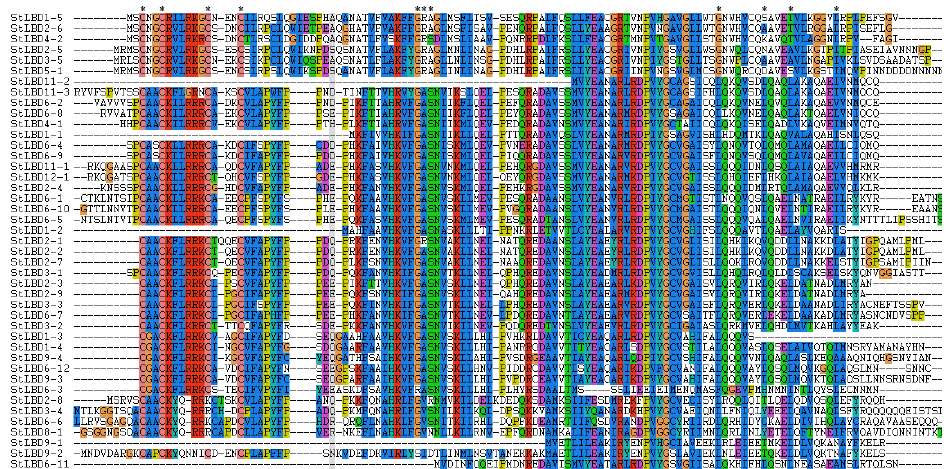
Figure 4. Potato LBD family conserved domain protein sequence alignment. The amino acid sequence of the potato LBD protein was aligned by Clustal X 1.83. “*” Indicates the CX2CX6CX3 zinc finger-like motif, GAS (Gly-Ala-Ser) block, and LX6LX3LX6L leucine zipper-like coiled-coil motif [14].